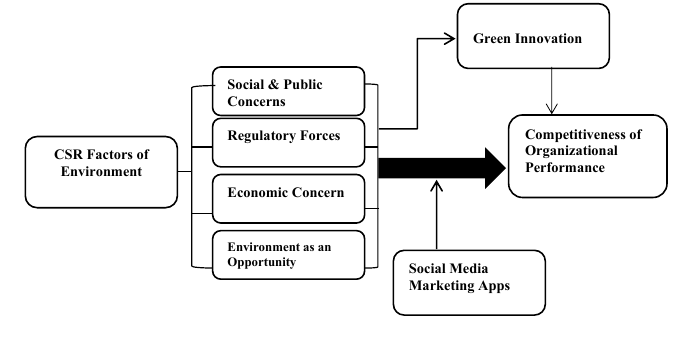
Fig. 1 – Modified Theoretical & Conceptual Modified Model. Source: own